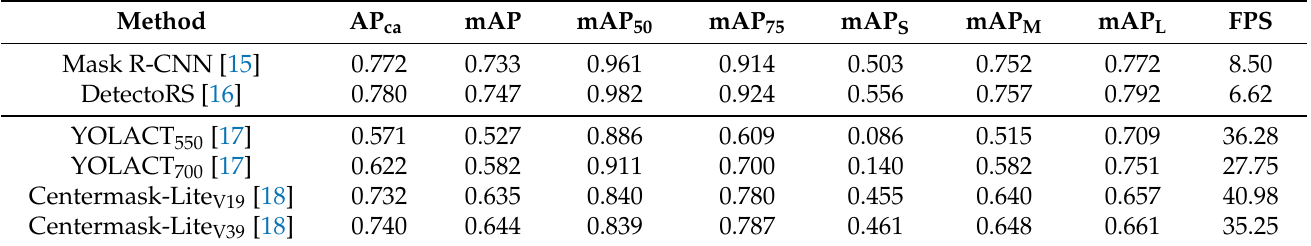
Table 3. Resulting instance segmentation APs and inference speed per method evaluated. The two first rows are robust methods and the rest are the real-time